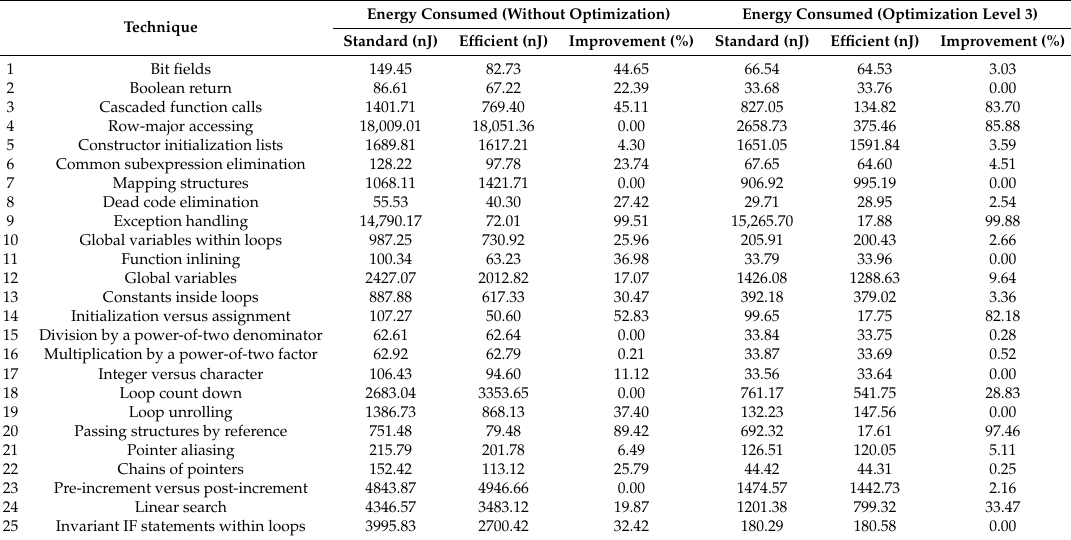
Table 4. Energy results and percentages of improvement in Raspberry Pi 3B+.